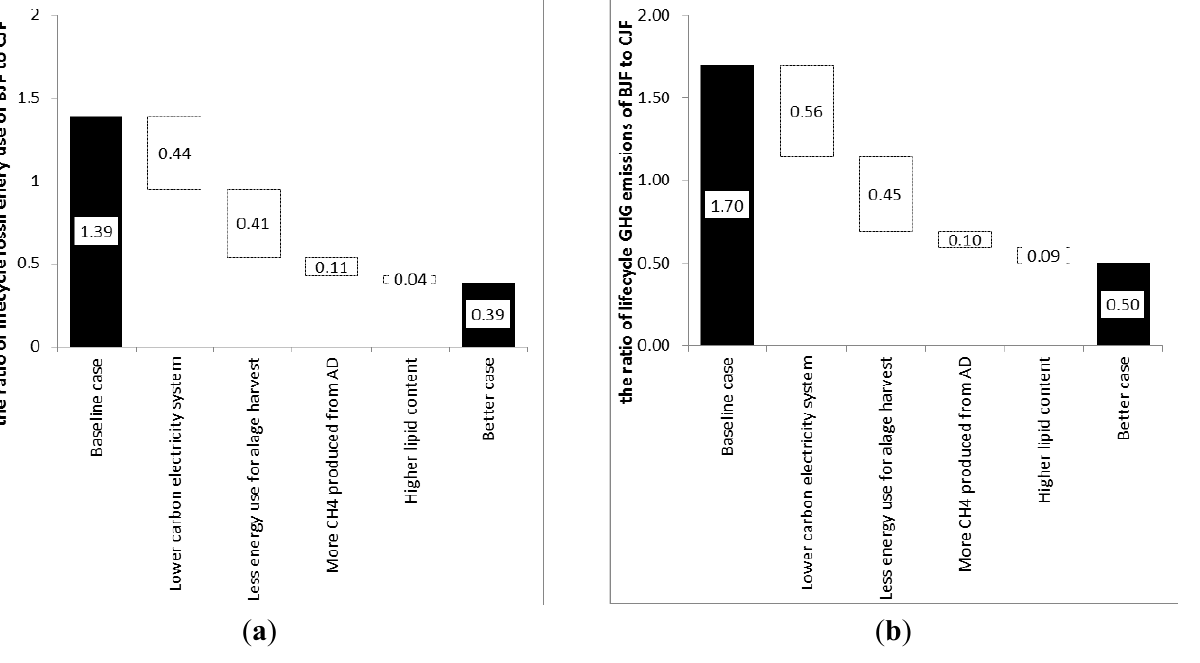
Figure 10. Life cycle analysis results for BJF in better case: ( a ) Life-cycle fossil energy use and ( b ) Life-cycle GHG